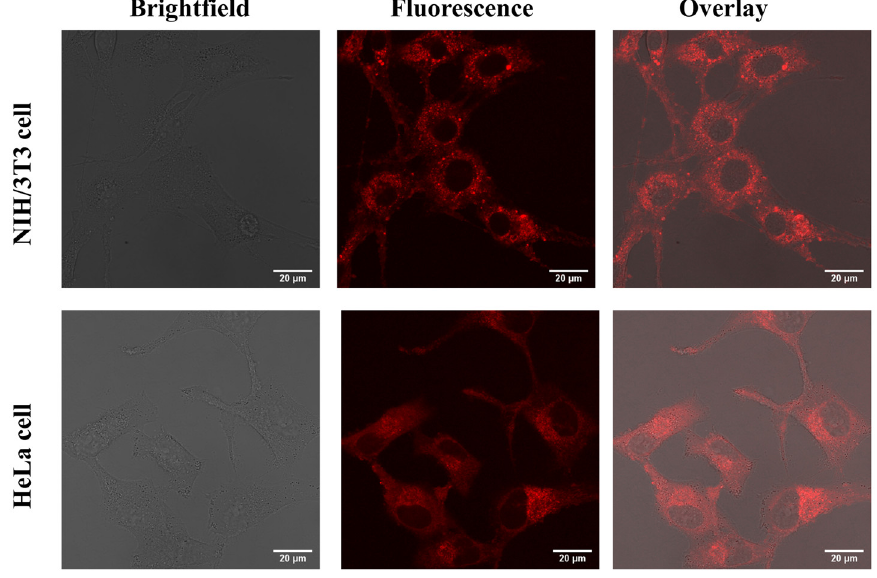
MTT test. The error bar represents the standard error of three trials.